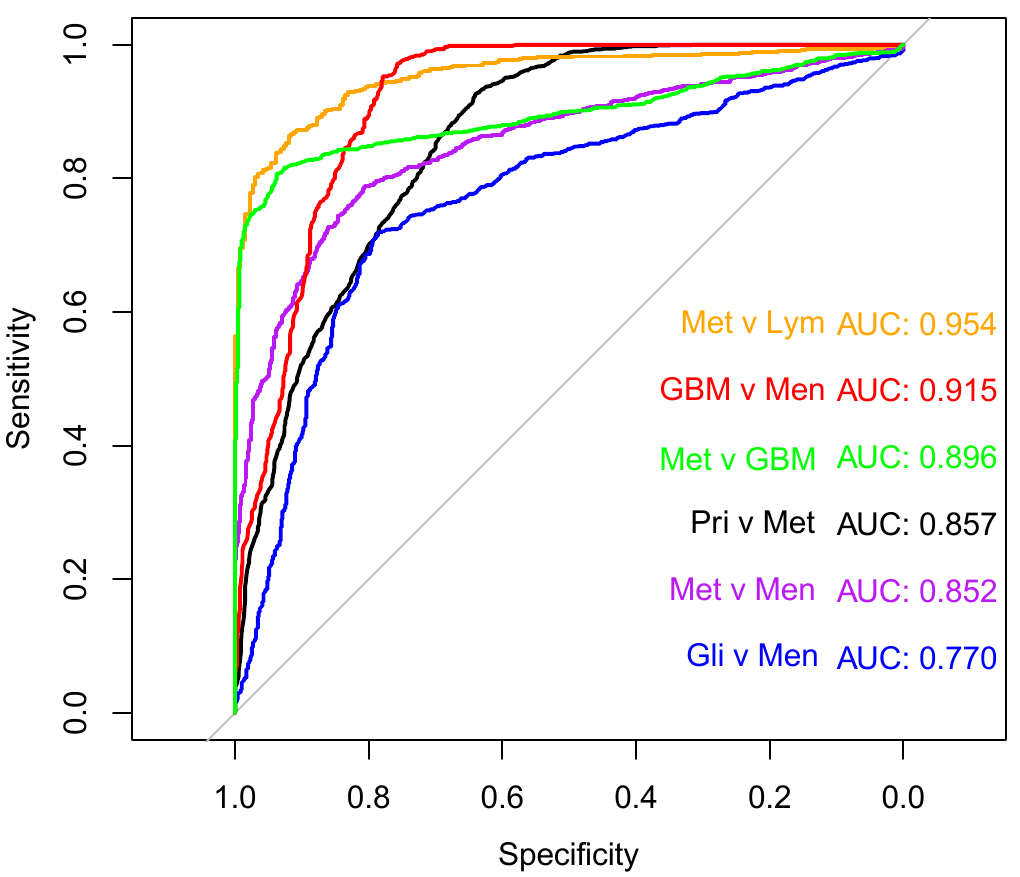
Figure 4. Receiver operator curves displaying the trade-off between sensitivity and specificity for the best model of each of the six brain tumour classifiers: primary (Pri) versus metastasis (Met), black; glioma (Gli) versus meningioma (Men), blue; glioblastoma (GBM) versus meningioma, red; metastasis versus GBM, green; metastasis versus primary central nervous system lymphoma (Lym), orange; metastasis versus meningioma, purple.